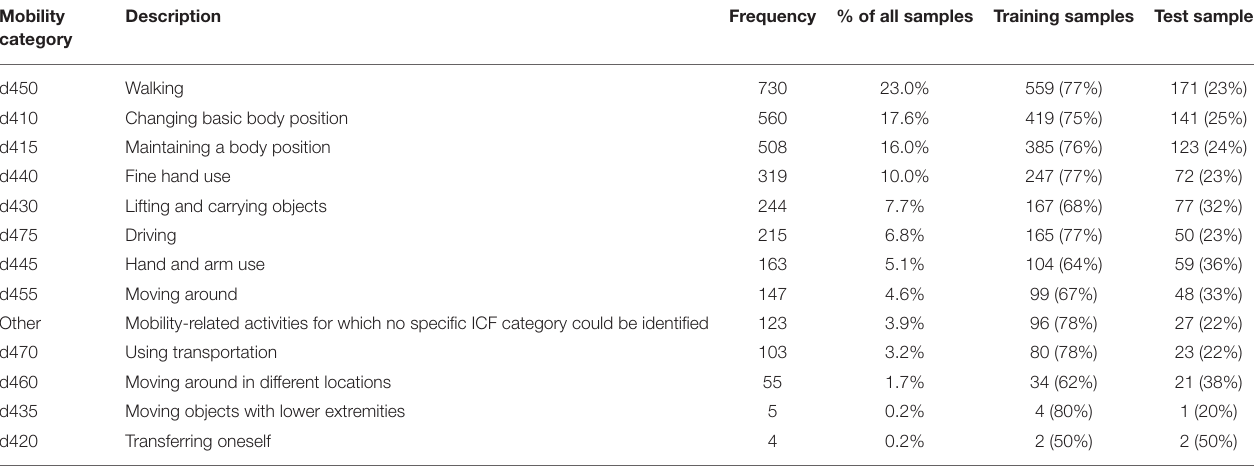
TABLE 3 | ICF category descriptions and frequencies for Mobility dataset (3,176 samples total). Mobility category